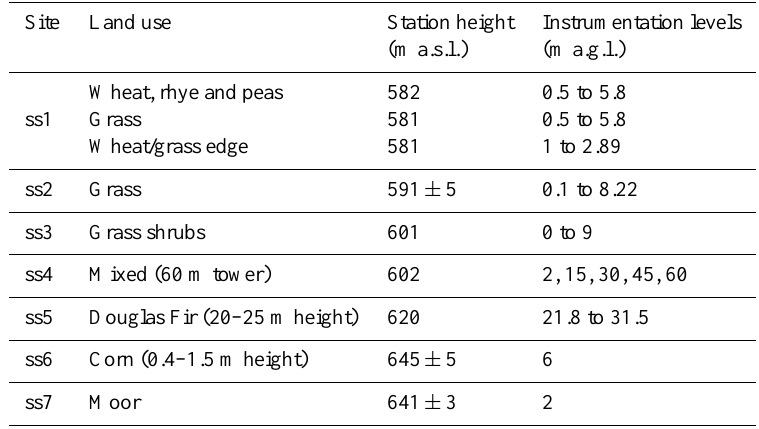
Table A1. Surface stations deployed during BLLAST: altitude, characteristics of the vegetation and measurements heights. The instruments used over each station are given in Table